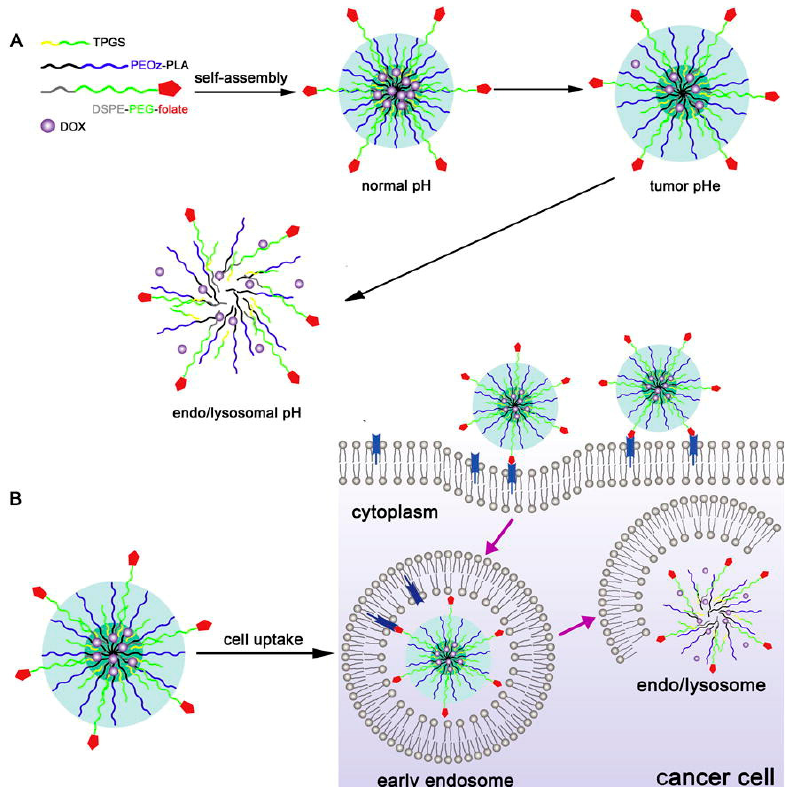
Figure 18. ( A ). The general overview of the synthesized copolymeric micelles modified with folate and the acid-triggered drug release from the pH-responsive micelles. ( B ). The general overview of synthesized copolymeric micelles for targeted and controlled drug delivery. Reprinted from [122].